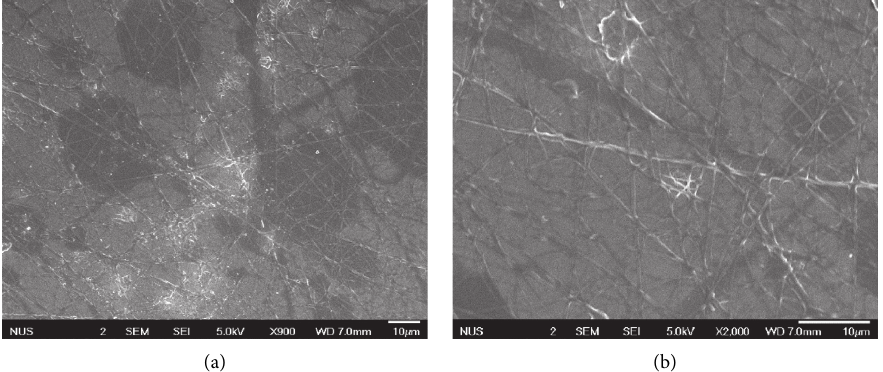
Figure 2: Scanning electron micrographs of PAA nanofibers at (a) × 900 and (b) ×